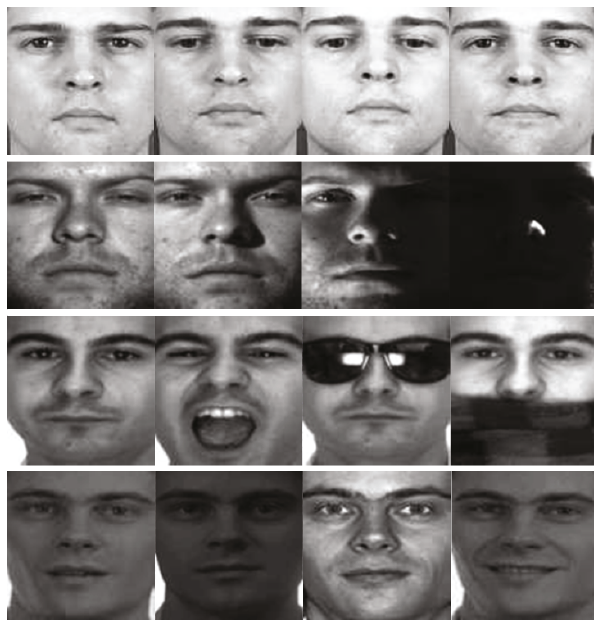
Figure 13: Examples of preprocessed images of (from top to bottom): the XM2VTS database, the EYB database, the AR database, and FERET